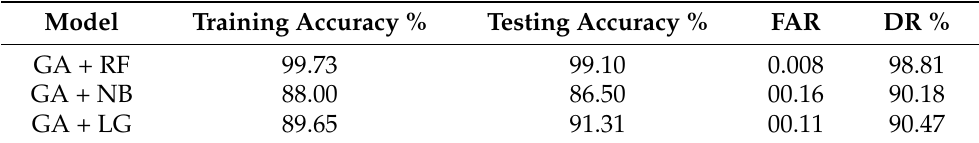
Table 7. Average comparison of different evaluation metrics of the proposed models.